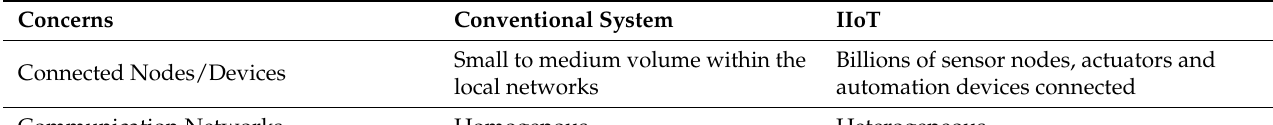
Table 2. The difference between conventional systems and IIoT security